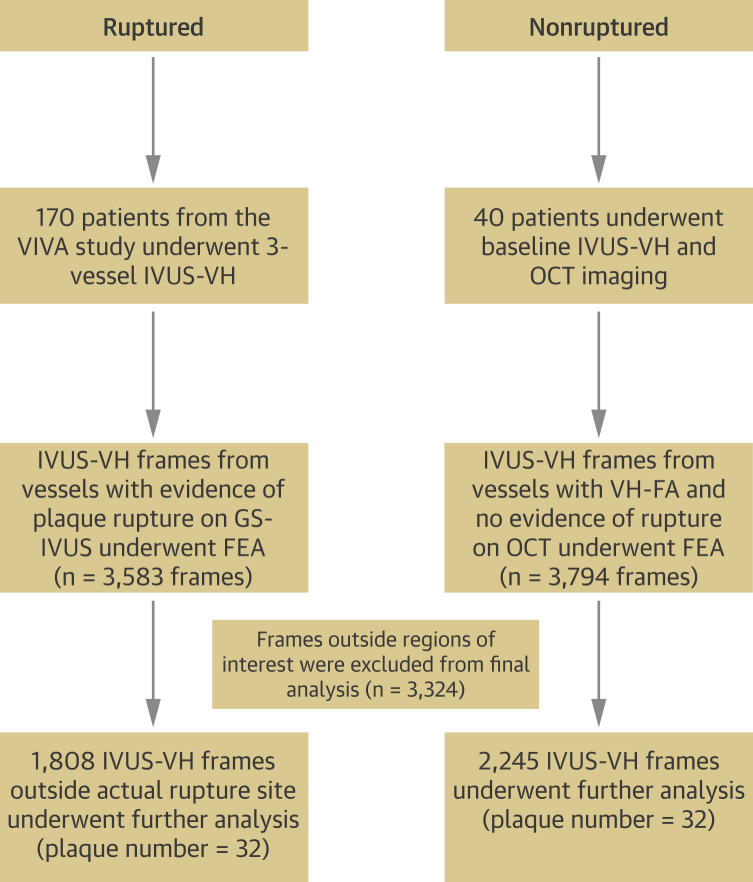
Schematic Representation of Patient and Plaque Populations Included in the StudyFEA = finite element analysis; OCT = optical coherence tomography; VH-FA = virtual histology fibroatheroma; VIVA = VH-IVUS in Vulnerable Atherosclerosis study.